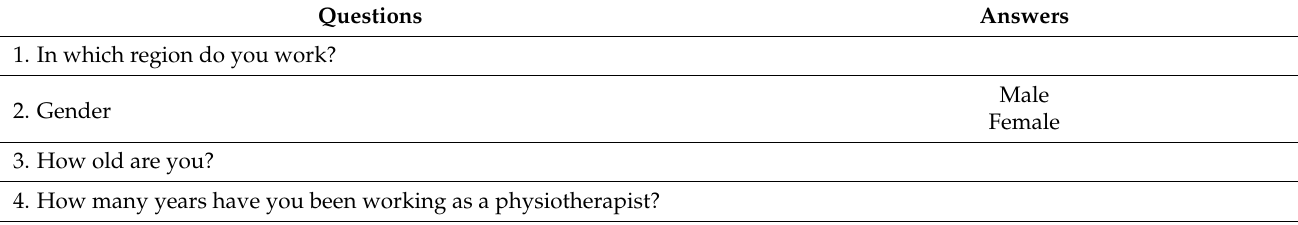
Table 1. Questionnaire used in the survey (English